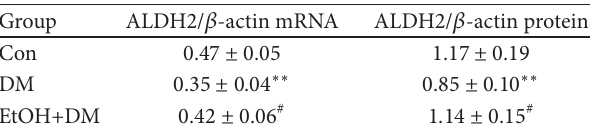
Table 3: Changes of ALDH2 mRNA and protein expressions in lung tissues in different